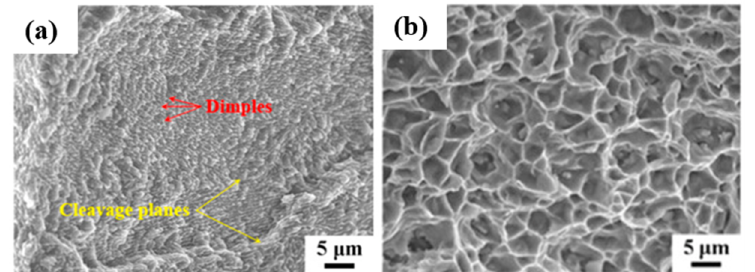
Figure 64. Fracture surfaces of AlSi10Mg SLM samples after tensile testing in the ( a ) as-prepared and ( b ) annealed (823 K, 2 h) condition [160]. Copyright 2016. Adapted with permission from Elsevier Science Ltd. under the license number 4803740322935 (Figure 8 [160]), dated 7 April 2020.